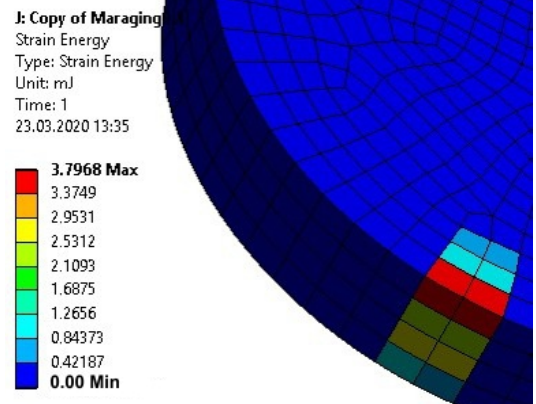
Figure 23. Energy of the plastic deformation of the upper element made of maraging steel loaded with 5000 N force.